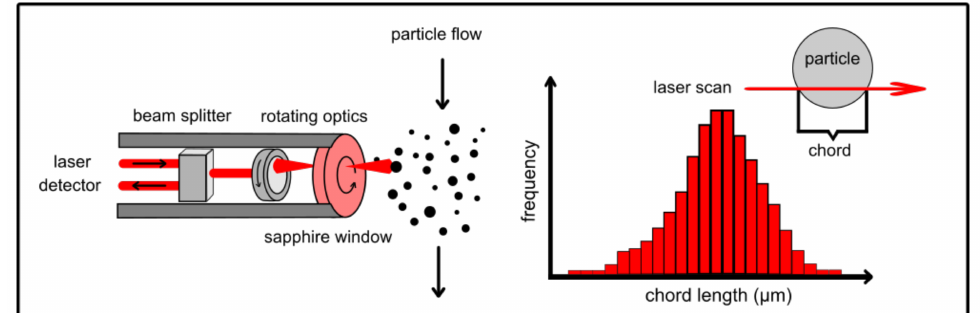
Figure 8. Laser scanner technology. The sensor setup is shown on the left, and the chord length distribution is shown on the